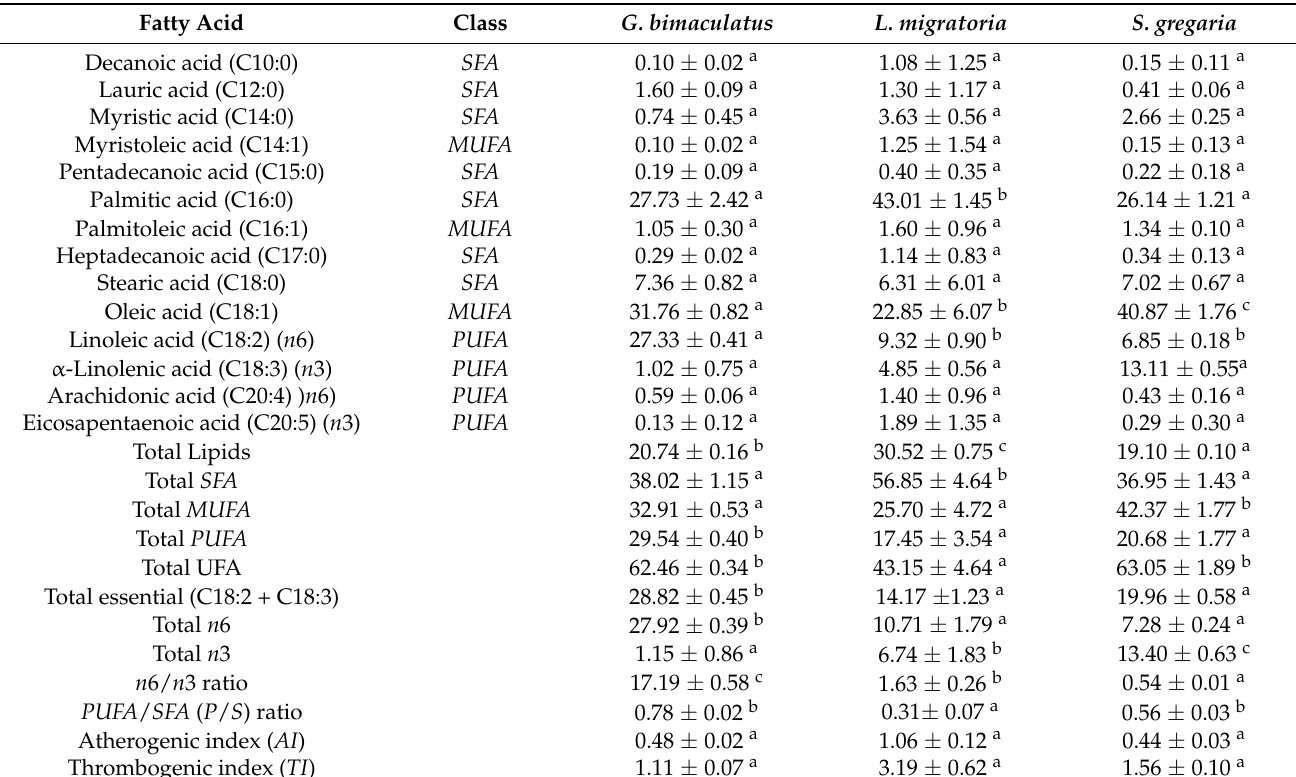
Table 4. Fatty acid profile (in g/100 g fatty acid) of G. bimaculatus , L. migratoria , and S. gregaria : each experimental value represents the mean ± standard deviation of triplicate determinations. G.